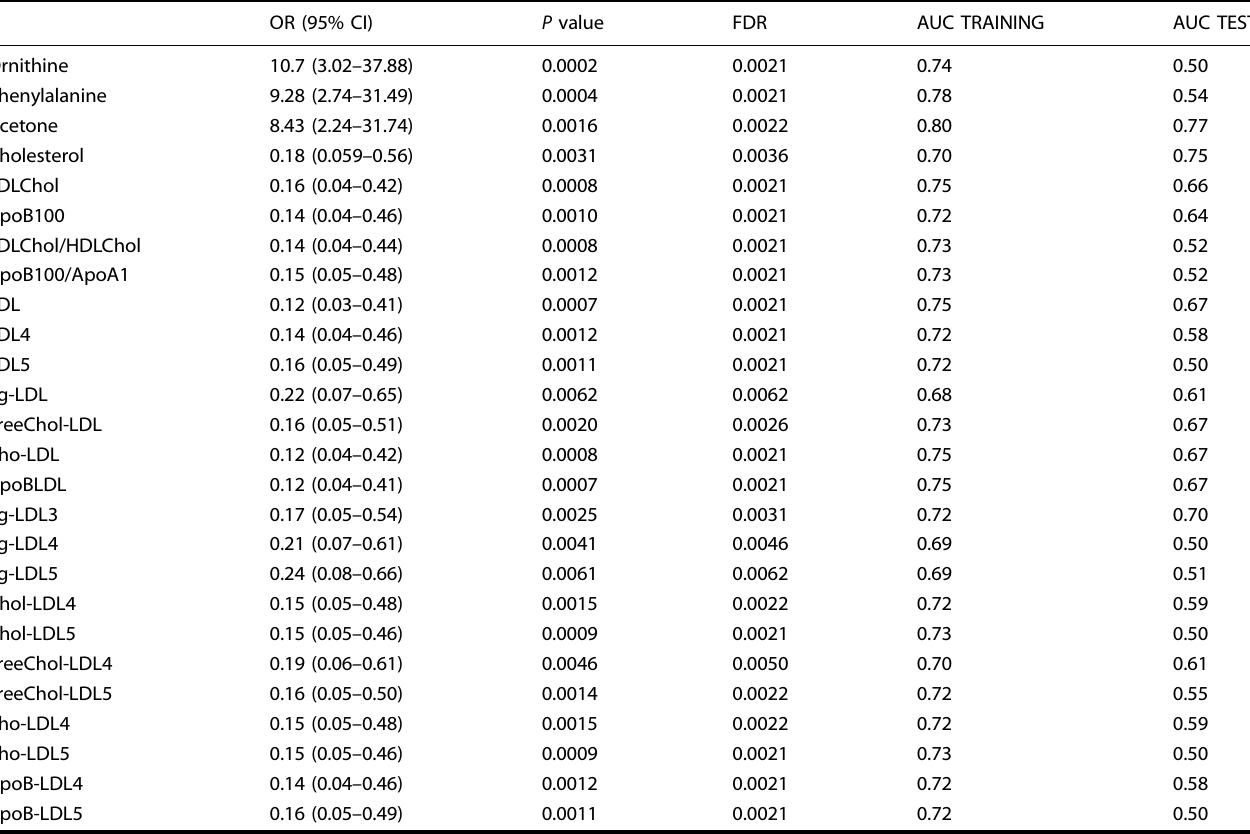
Table 3. Area under the ROC curve (AUC) values for male subjects of the training and the test set. OR (95% CI) P value FDR AUC TRAINING AUC TEST